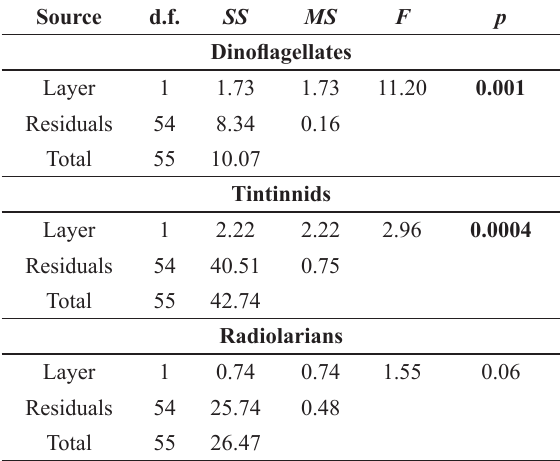
Results of the PERMANOVA analyses performed on the Bray-Curtis distance matrices of the dinoflagellate, tintinnid ciliates, and radiolarian assemblages in the SML and SSL layers.